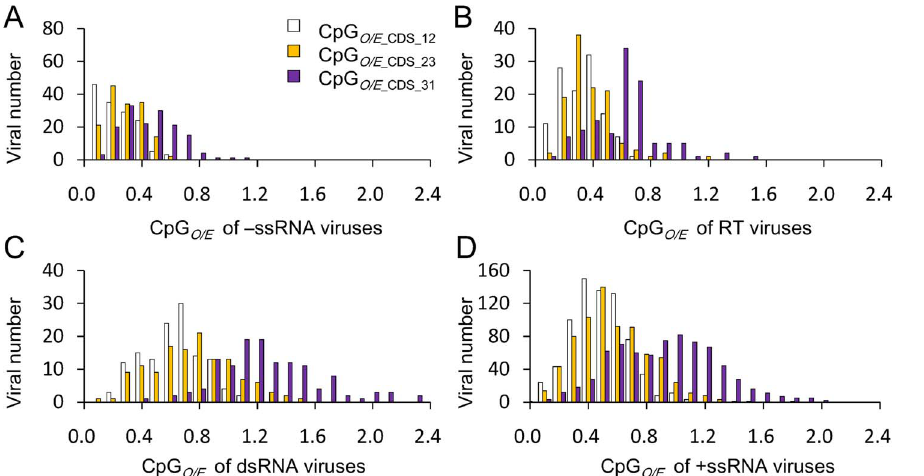
Figure 3. CpG usage pattern of RNA viruses within coding region. ( A–D ) Distribution of CpG at the three locations in the coding regions of 2 ssRNA, RT, dsRNA, and + ssRNA viruses, respectively.